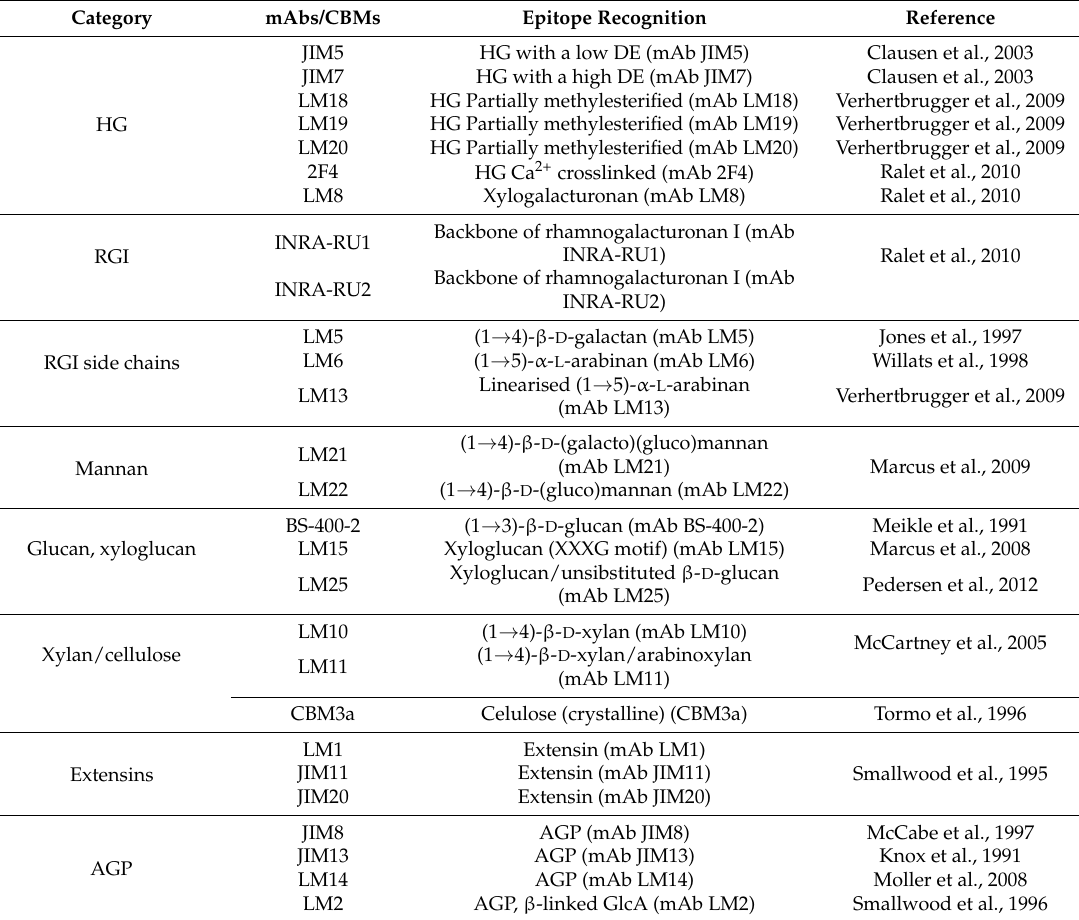
Table 1. The commonly used and characterised mAbs/CBMs for different groups of cell wall